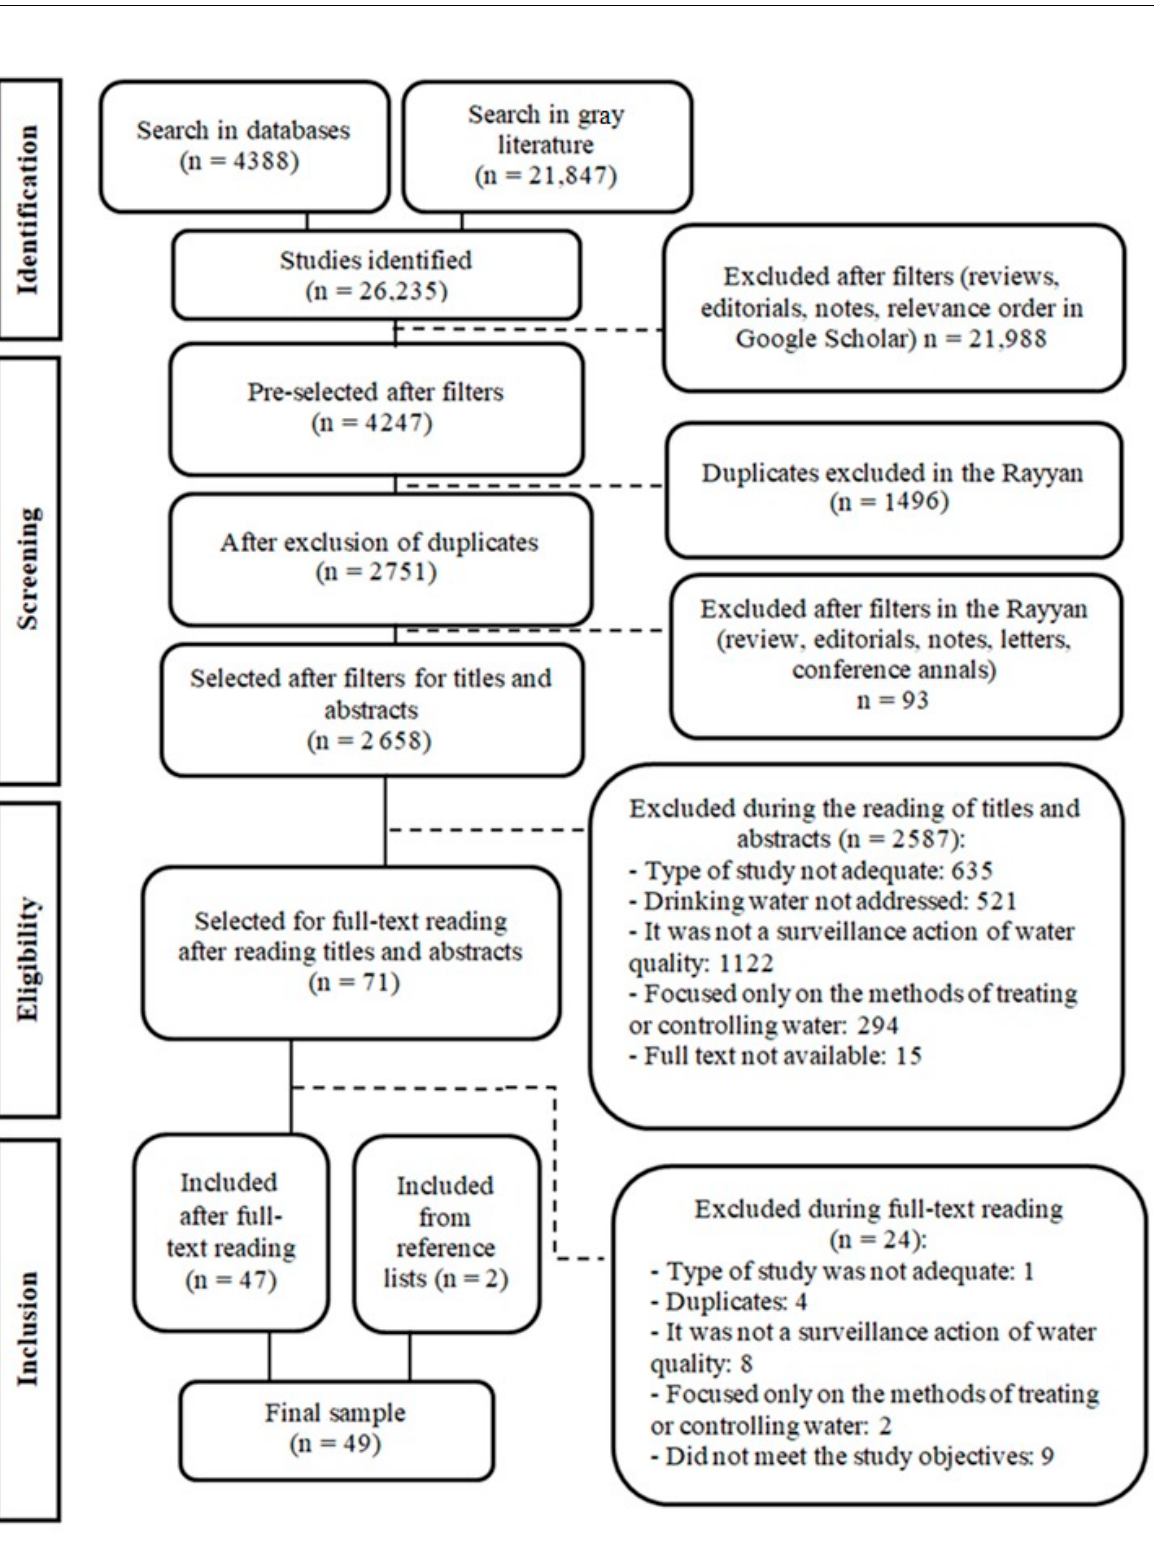
Figure 1. Flowchart of study selection adapted from the Preferred Reporting Items for Systematic Review and Meta-Analyzes [20].